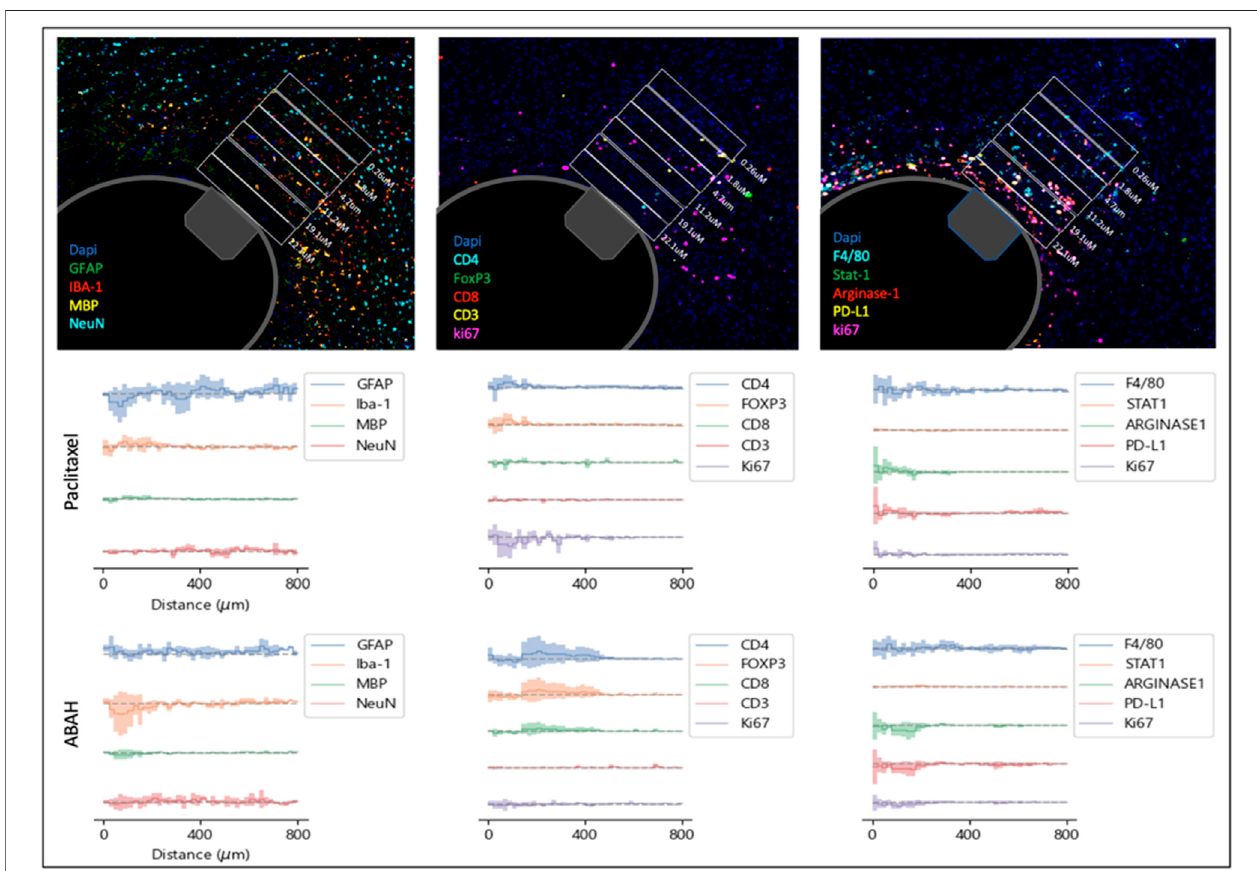
FIGURE3| (Top)Multiplexedimmuno fl uorescenceanalysisofdistance-dependentdrugeffectsusing13cellularandphenotypemarkers.Rectangularboxesserve as distance markers of 90um width. Example is shown for paclitaxel at t = 7d in B6 hMAPT mice (Bottom) Spatial plots of marker expression indicating concentration- dependent drug effects, shown for paclitaxel and ABAH. Each plot is generated by subtracting the expression levels from control regions from the respective drug- exposed ROI. Lines represent the mean value from n = four to six mice (shaded area = SD).